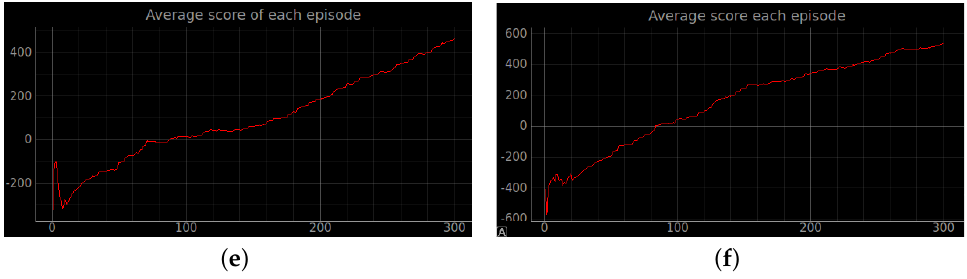
Figure 11. Average total reward value per episode for stage 3. The simulation results show that the episodes of RND3QN algorithm to learn an effective policy are half of those of DQN algorithm.